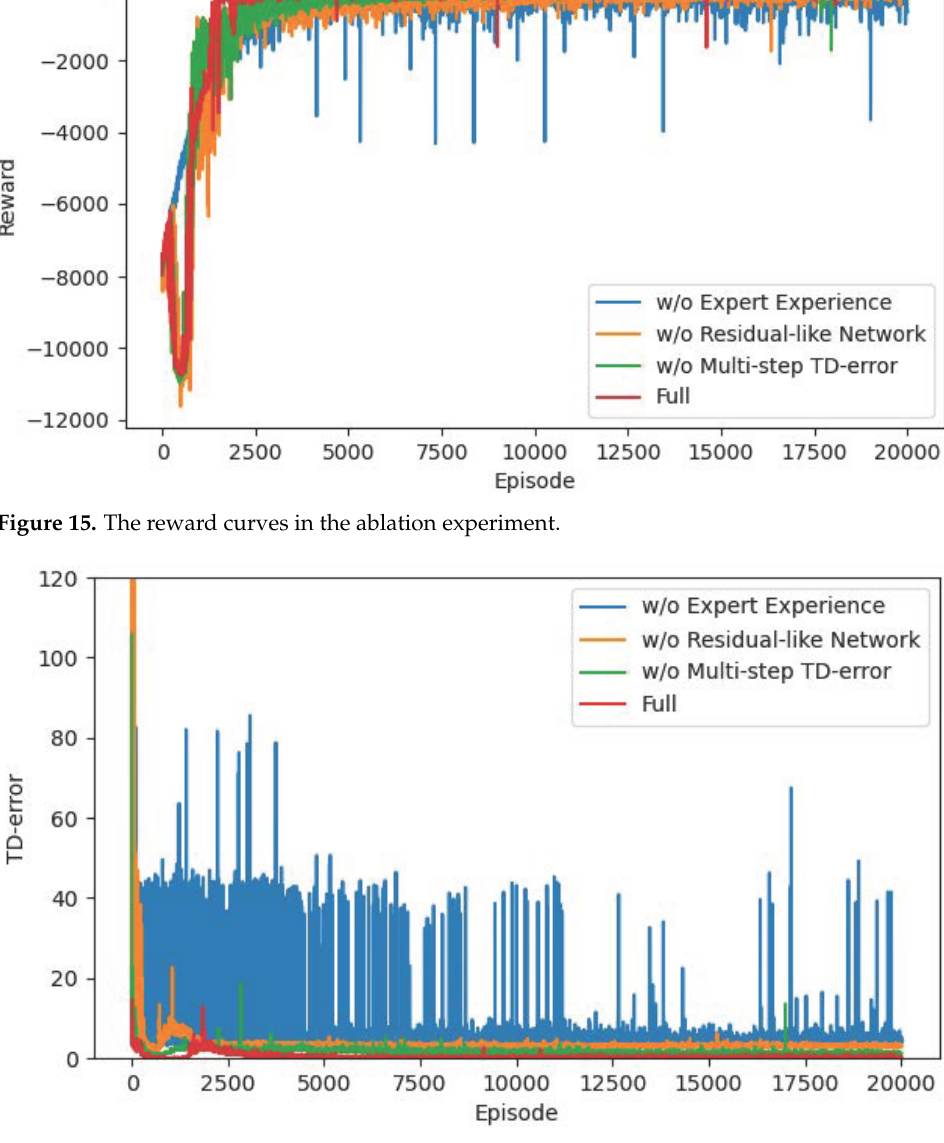
Figure 16. The TD-error curves in the ablation